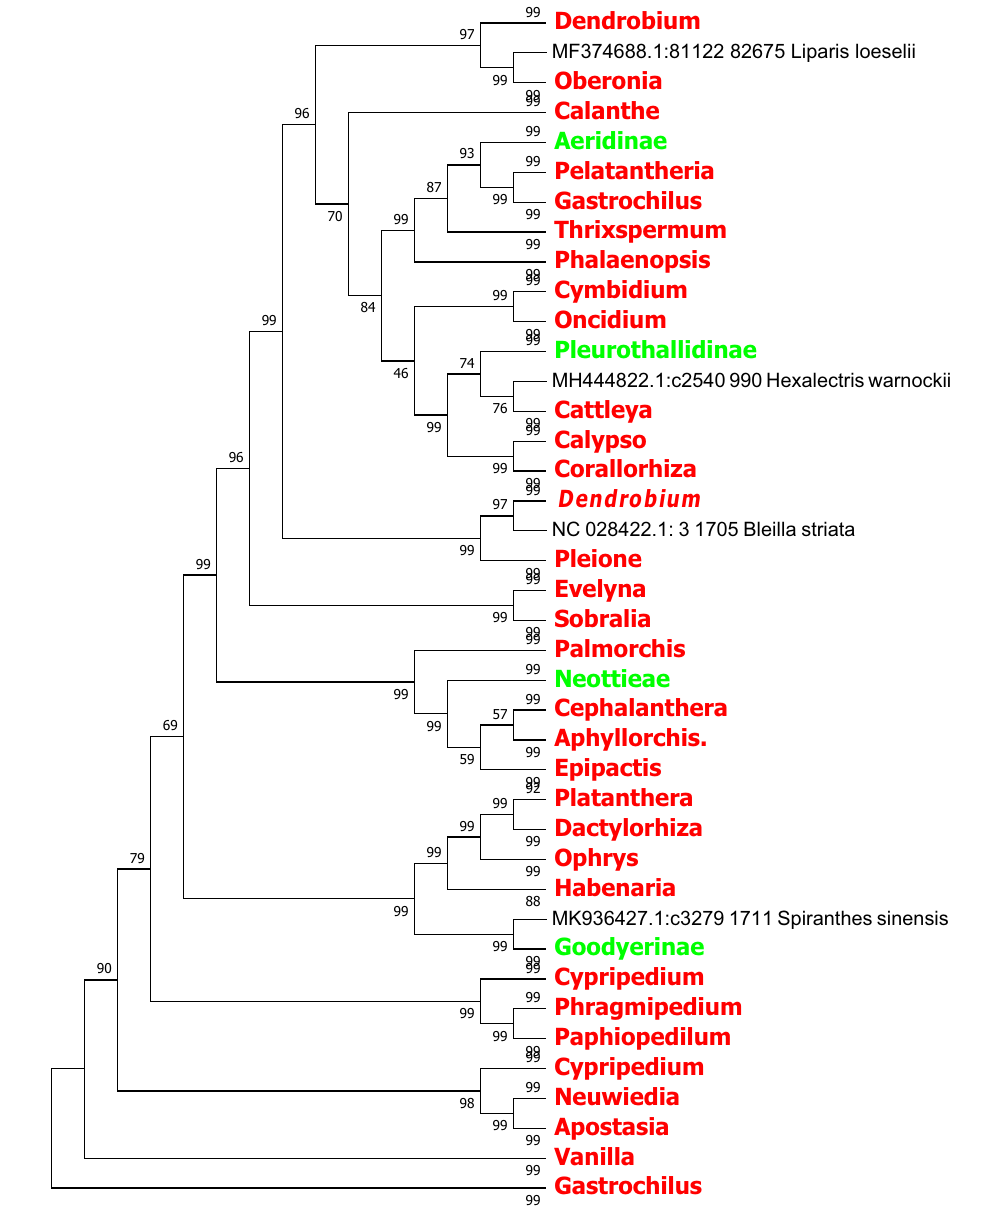
Figure 7. The NJ tree of Orchidaceae from analysis of the matK + ycf1 sequence based on the K2P model. Names tagged in red indicates the genus and tagged in green showed the subtribe; The Numbers on the branches represent more than or equal to 50 percent support after the 1000 bootstrap replications test; Numbers following taxon names showed the number of